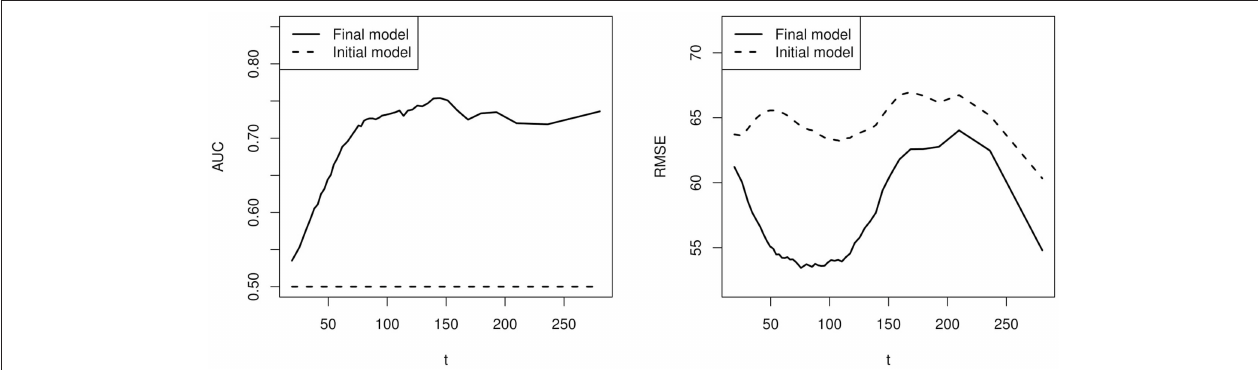
FIGURE 5 | A comparison of prediction accuracy between the model selected by cross validation and a baseline model without using individual specific event history.